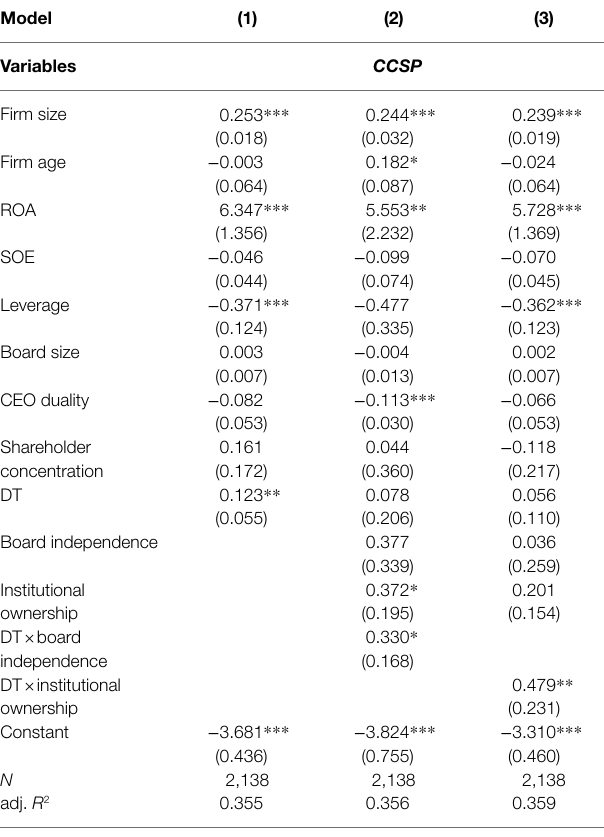
TABLE 6 | Robustness check: Alternative proxy for CSP. Model